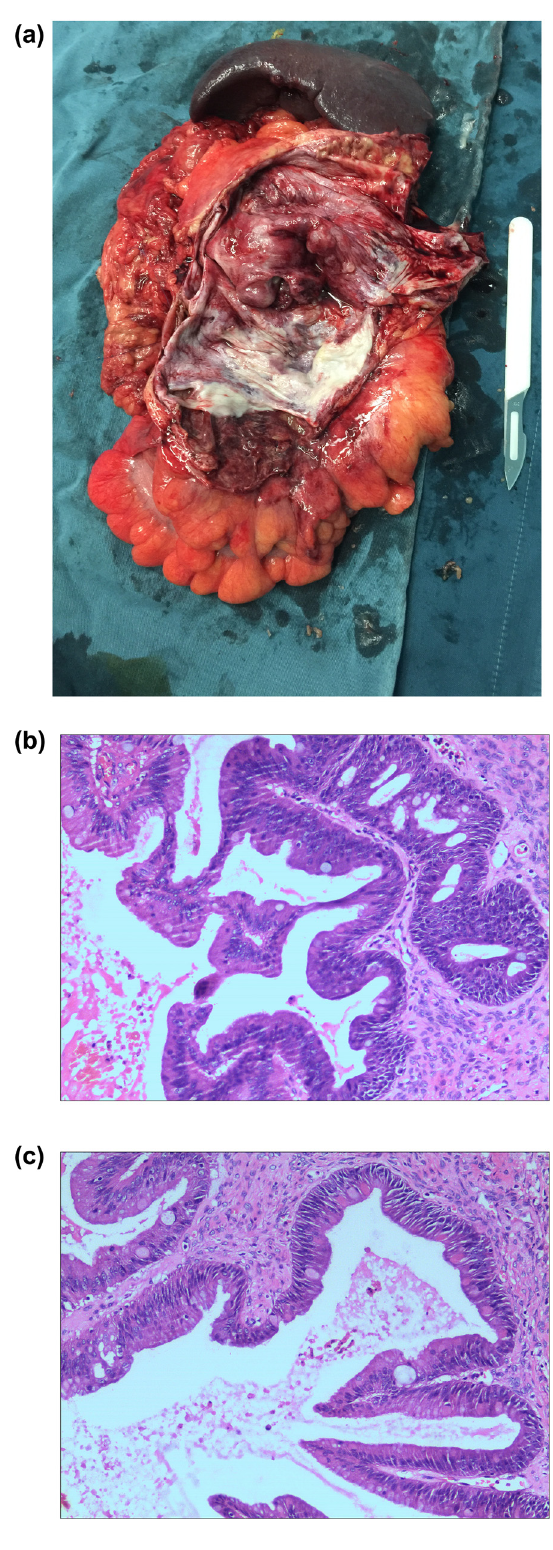
Figure 2: ( a ) Gross examination showing a 27 cm long, 2.5 cm dia - meter colon specimen without a di ff erence in the mucous mem - brane. The external side of the intestinal wall showed a cystic neoplasm of 16 cm × 12 cm × 3.5 cm, with a cystic wall thickness